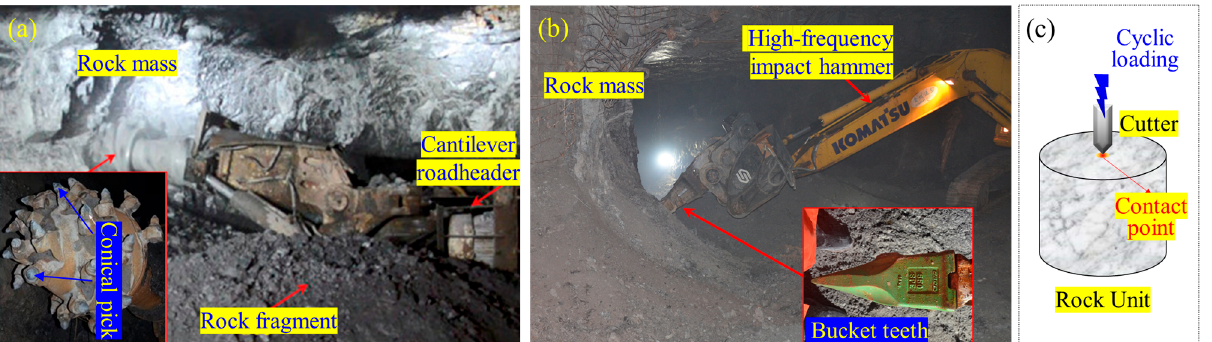
Figure 1. ( a ) Roadheader with pick; ( b ) high-frequency impact hammer with bucket teeth; ( c ) mechanical model of rock unit exposed to the disturbance from mechanized excavation.